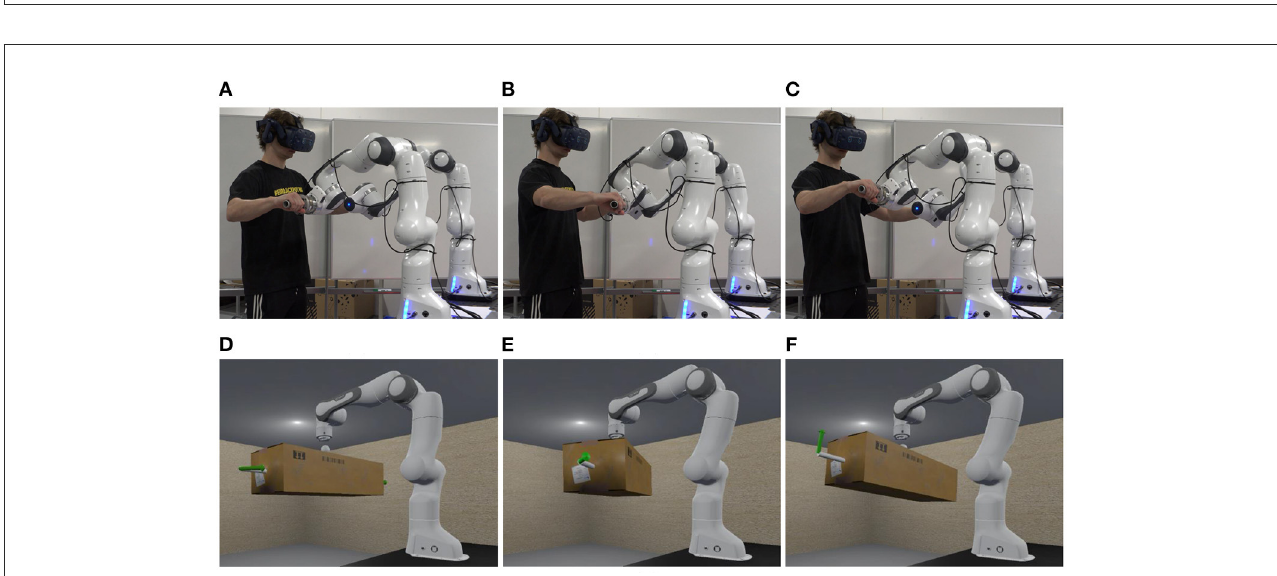
FIGURE6 Snapshots of an experiment of scenario 2 at 5s (A) , 22s (B) , and 29s (C) , and the corresponding snapshots of the VR scene in the visual rendering module at 5s (D) , 22s (E) , and 29s (F)